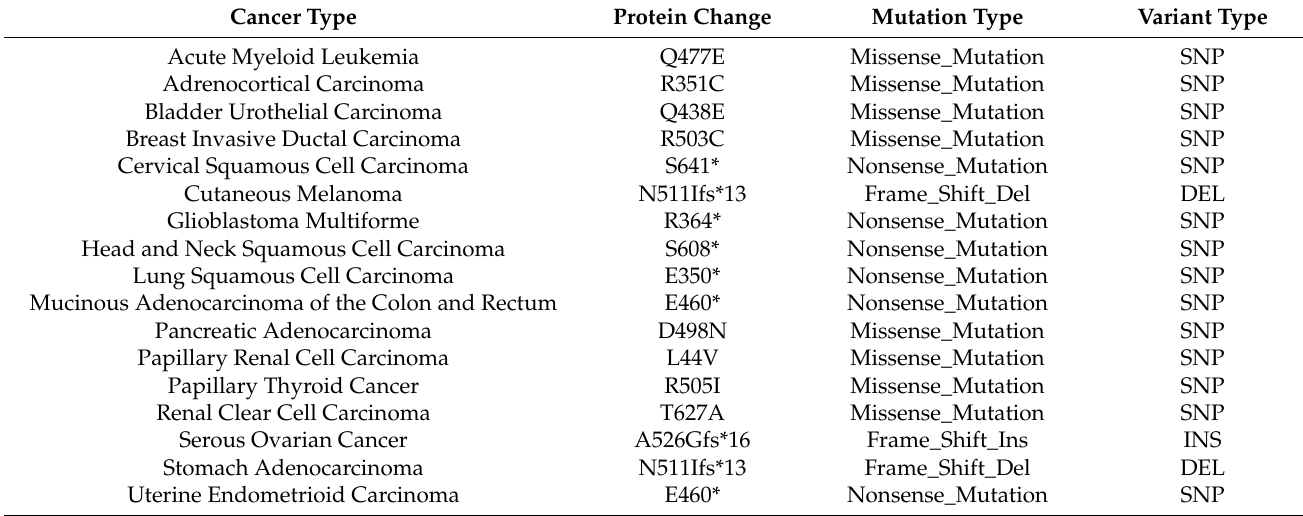
Table 2. Association of MRE11 mutations with different types of